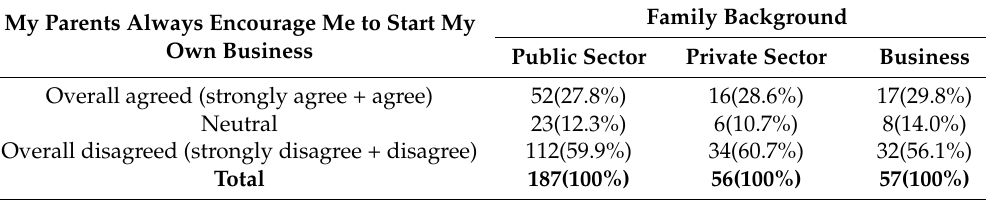
Table 5. The relationship between family background, study area and starting own business.